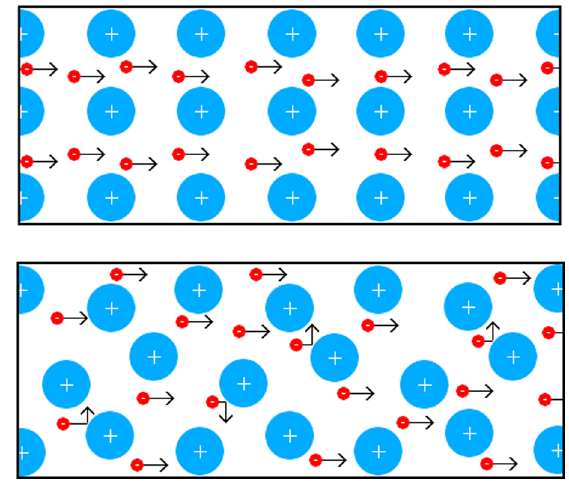
FIG. 8. A microscopic model of conductors (top) and resistors (bottom) based on the Drude